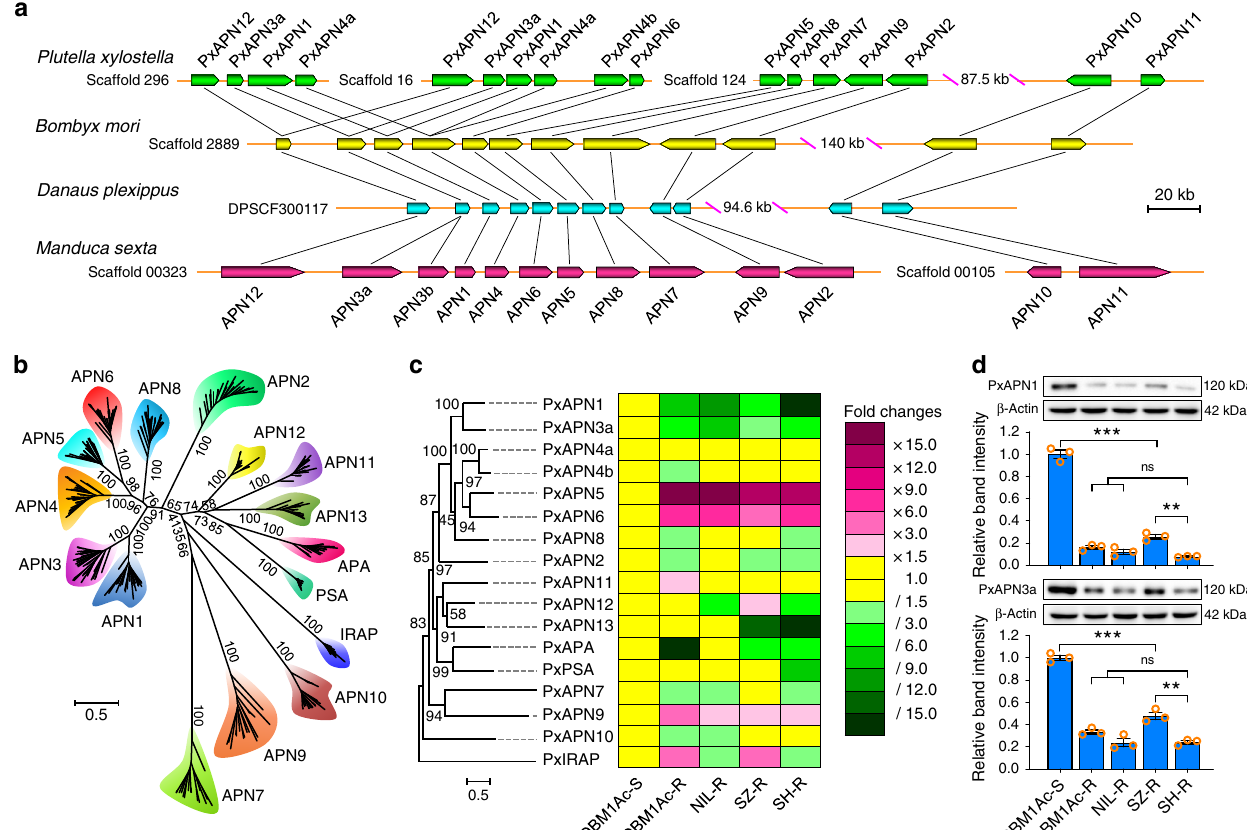
Fig. 1 Genome-wide cloning and characterization of the APN gene family in P. xylostella . a Synteny analysis of APN1-12 genes among four lepidopteran insects. b Phylogenetic analysis of the currently available 340 lepidopteran APN and other M1 aminopeptidases by maximum likelihood method based on the optimized LG + G model at 495 aligned amino acid positions. c The constitutive transcription pro fi les of PxAPN and other M1 aminopeptidase genes in midgut tissues of fourth-instar larvae from all the Bt-susceptible and -resistant P. xylostella strains as determined by qPCR analysis. For each gene, the expression fold changes are color-coded according to the gradient, magenta and green rectangles indicate signi fi cant up- and down-regulation, respectively (ratio >1.5-fold in either direction), whereas yellow rectangles indicate no signi fi cant transcription variations. Genes are organized according to their phylogenetic tree constructed by the maximum likelihood method based on the optimized LG + G + I model at 690 aligned amino acid positions. d The relative expression levels of PxAPN1 and PxAPN3a proteins in BBMV samples of fourth-instar larvae from different strains. Both the detection of PxAPN protein levels by Western blots (upper row) and quantitative estimation of band intensity by densitometry (graph) are presented. Data are presented as mean values ( c ) and mean values ± SEM ( d ), n = 3 biologically independent samples, * p < 0.05, ** p < 0.01, *** p < 0.001, ns, not signi fi cant, one-way ANOVA with Holm – Sidak ’ s test was used in ( c ) and ( d ) for comparison. Source data are provided as a Source Data fi